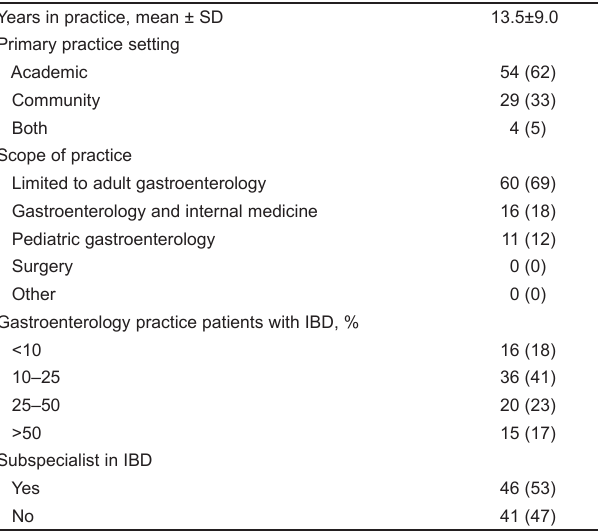
TABLE 1 Practice characteristics of